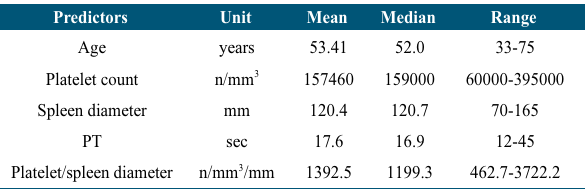
Table 2: Main clinical and biochemical characteristics of the study population.